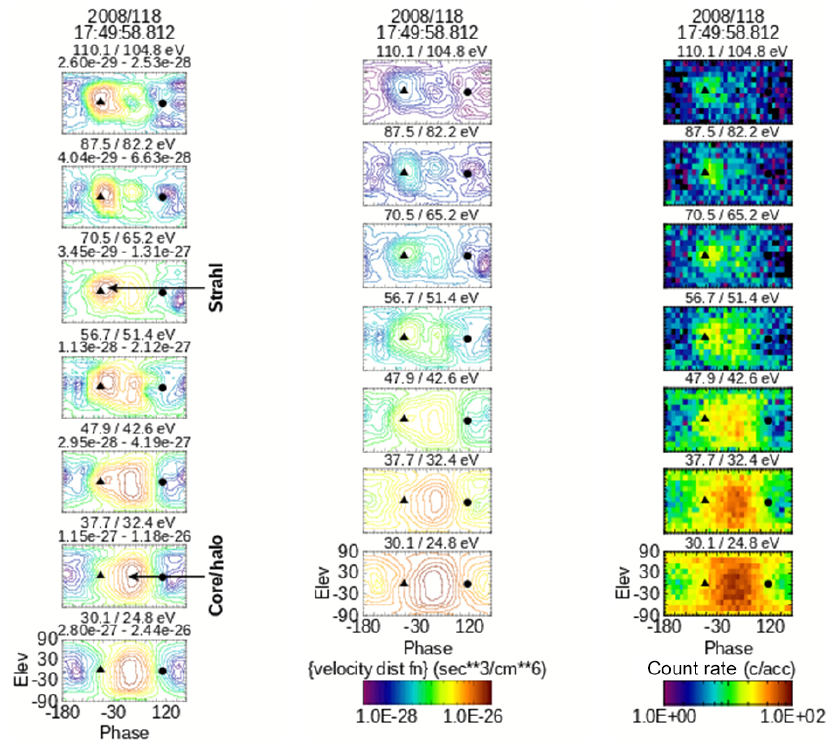
Figure 1. Example φ – θ plots of a solar wind eVDF. All columns of plots show the same set of solar wind data but with different formatting options. The first two columns of plots illustrate different scaling formats. The left-hand column of plots is auto-scaled, while the center column uses a common scaling. The strahl and core/halo populations are identified in the first column of plots. The right-hand column of plots shows the data in raw format (cntsacc − 1 ) allowing for the statistical importance of the data to be followed. Individual colored tiles are identical in area to the instrument angular